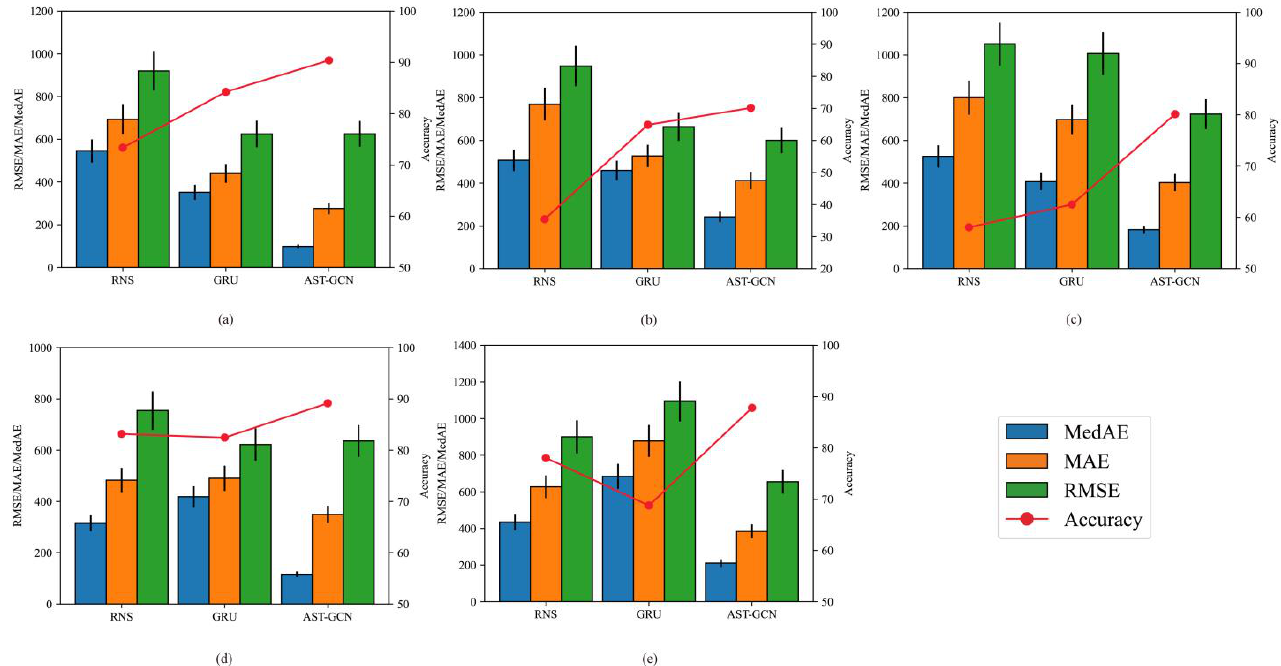
Figure 12. Comparison of prediction accuracy: ( a ) P1 well; ( b ) P2 well; ( c ) P3 well; ( d ) P4 well; ( e ) P5 well.